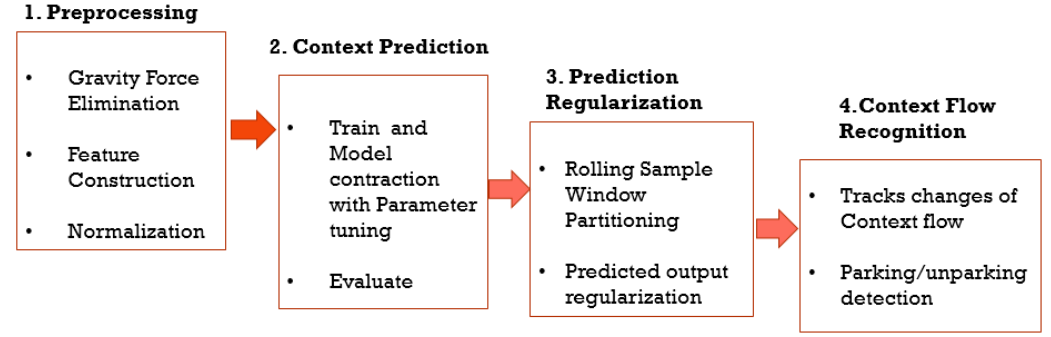
Figure 7. Sub-processes of major steps of the proposed system.